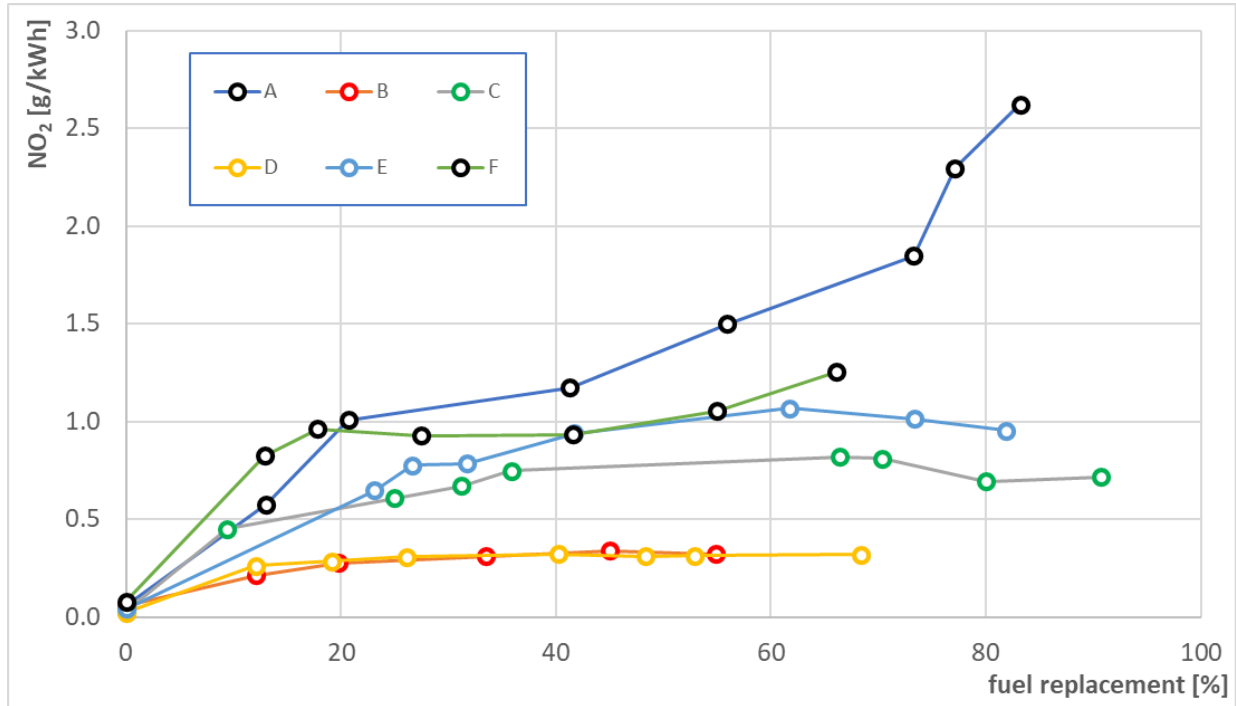
Figure 6. Curves from A to F showing the changes in the emission of nitric oxide as the comparison of exhaust gas temperature noted only in single fuel (diesel) working mode for individual engine operating points, where the rotation speed, power, and torque were constant, as a dual fuel mode (where engine uses CNG and diesel fuel) replacement function.